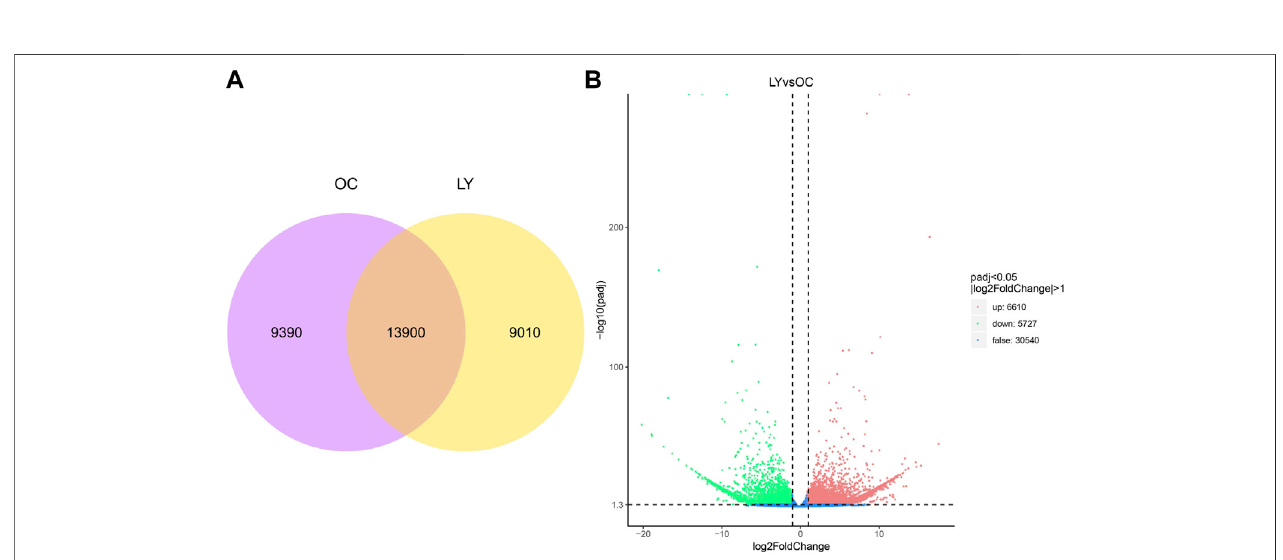
FIGURE 3 | Determination of gene expression level and identi fi cation of differentially expressed genes. Venn diagram indicating the numbers of genes expressed under different species (A) . OC, O cuniculus ; LY, L. yarkandensis. Volcano diagram of gene differential expression analysis under different species (B) . The abscissa representsthe gene expression multiple, and the ordinate representsthe statistical signi fi cance ofgene expression changes. The lowerthe corrected p -value, the larger the-log10 (corrected p -value) is.Themoresigni fi cantthedifferenceis.Thedots inthe fi gurerepresentgenes,withblue dotsrepresentinggeneswithnosigni fi cant difference, red dots representing genes with signi fi cant difference up-regulation, and green dots representing genes with signi fi cant down-regulation.